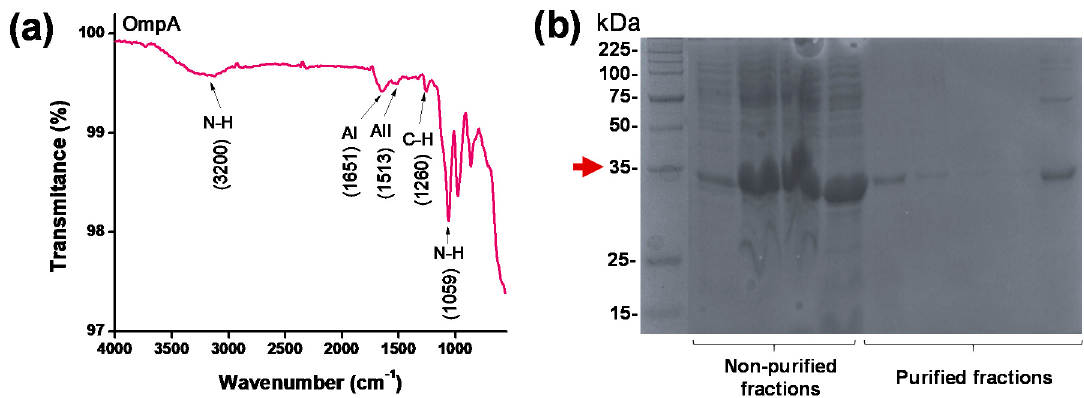
Figure 1. ( a ). FTIR spectrum of the dried OmpA protein. ( b ). Sodium dodecyl sulfate polyacrylamide gel electrophoresis (SDS-PAGE) of collected fractions during the purification procedure. Lane 1